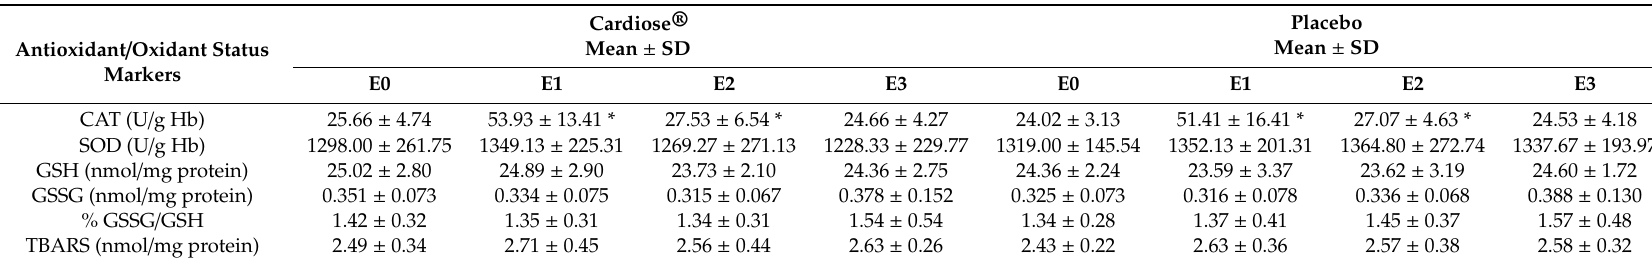
Table 4. Antioxidants and TBARS measured in repeated sprint test. Antioxidant markers were evaluated prior to the testing session (pre VT1 test, and 5 h after supplementation) [E0], post repeated sprint test [E1], post second VT1 test [E2], and 24 h after the end of the testing session